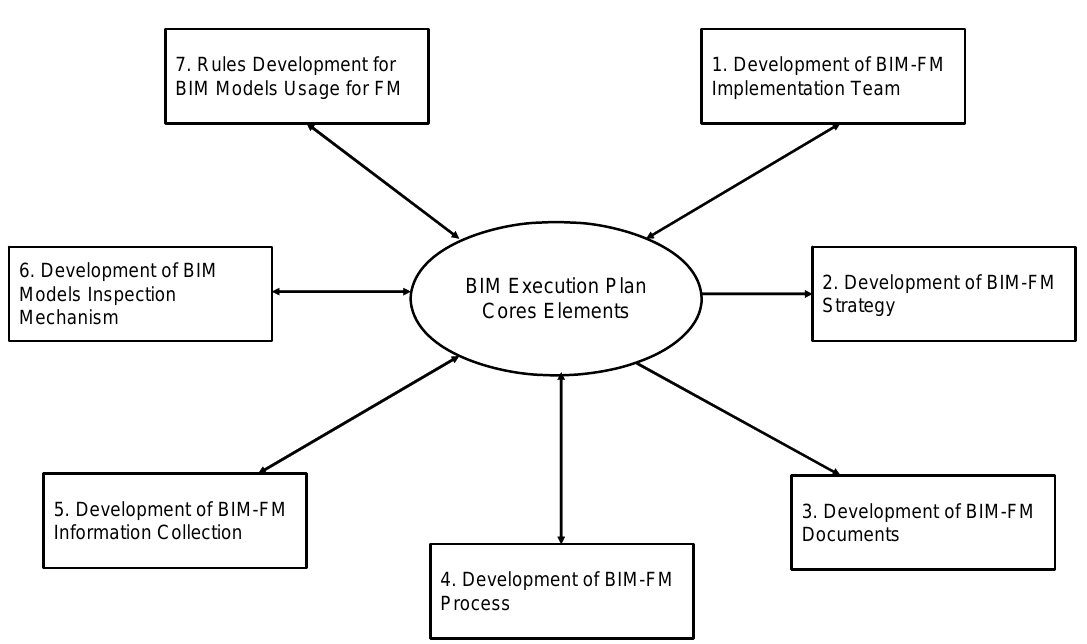
Figure 2. Proposed seven BIM execution plan core elements for BIM ‐ FM purpose.